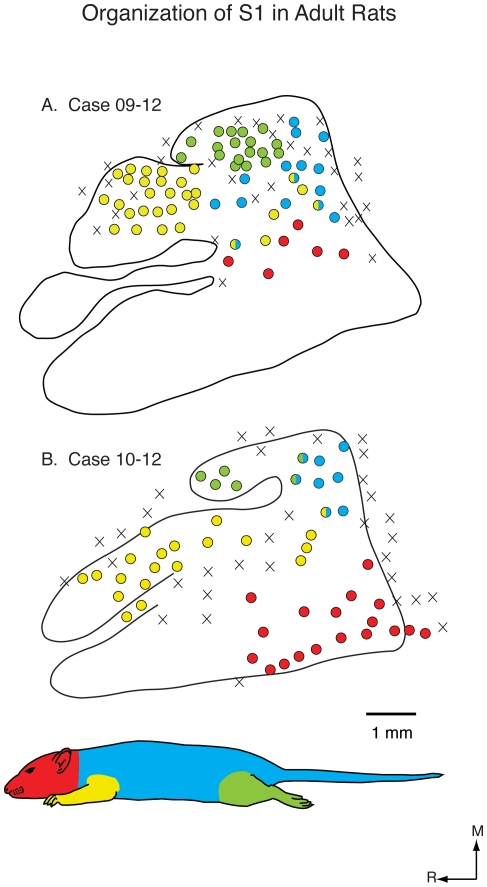
Functional S1 maps in adult rats.Reconstructed functional maps of primary somatosensory cortex in adult rats (A and B). In adult rats the topographic organization is precise and consistent across animals and similar to that previously described (Chapin and Lin, 1984). Conventions as in previous figures.